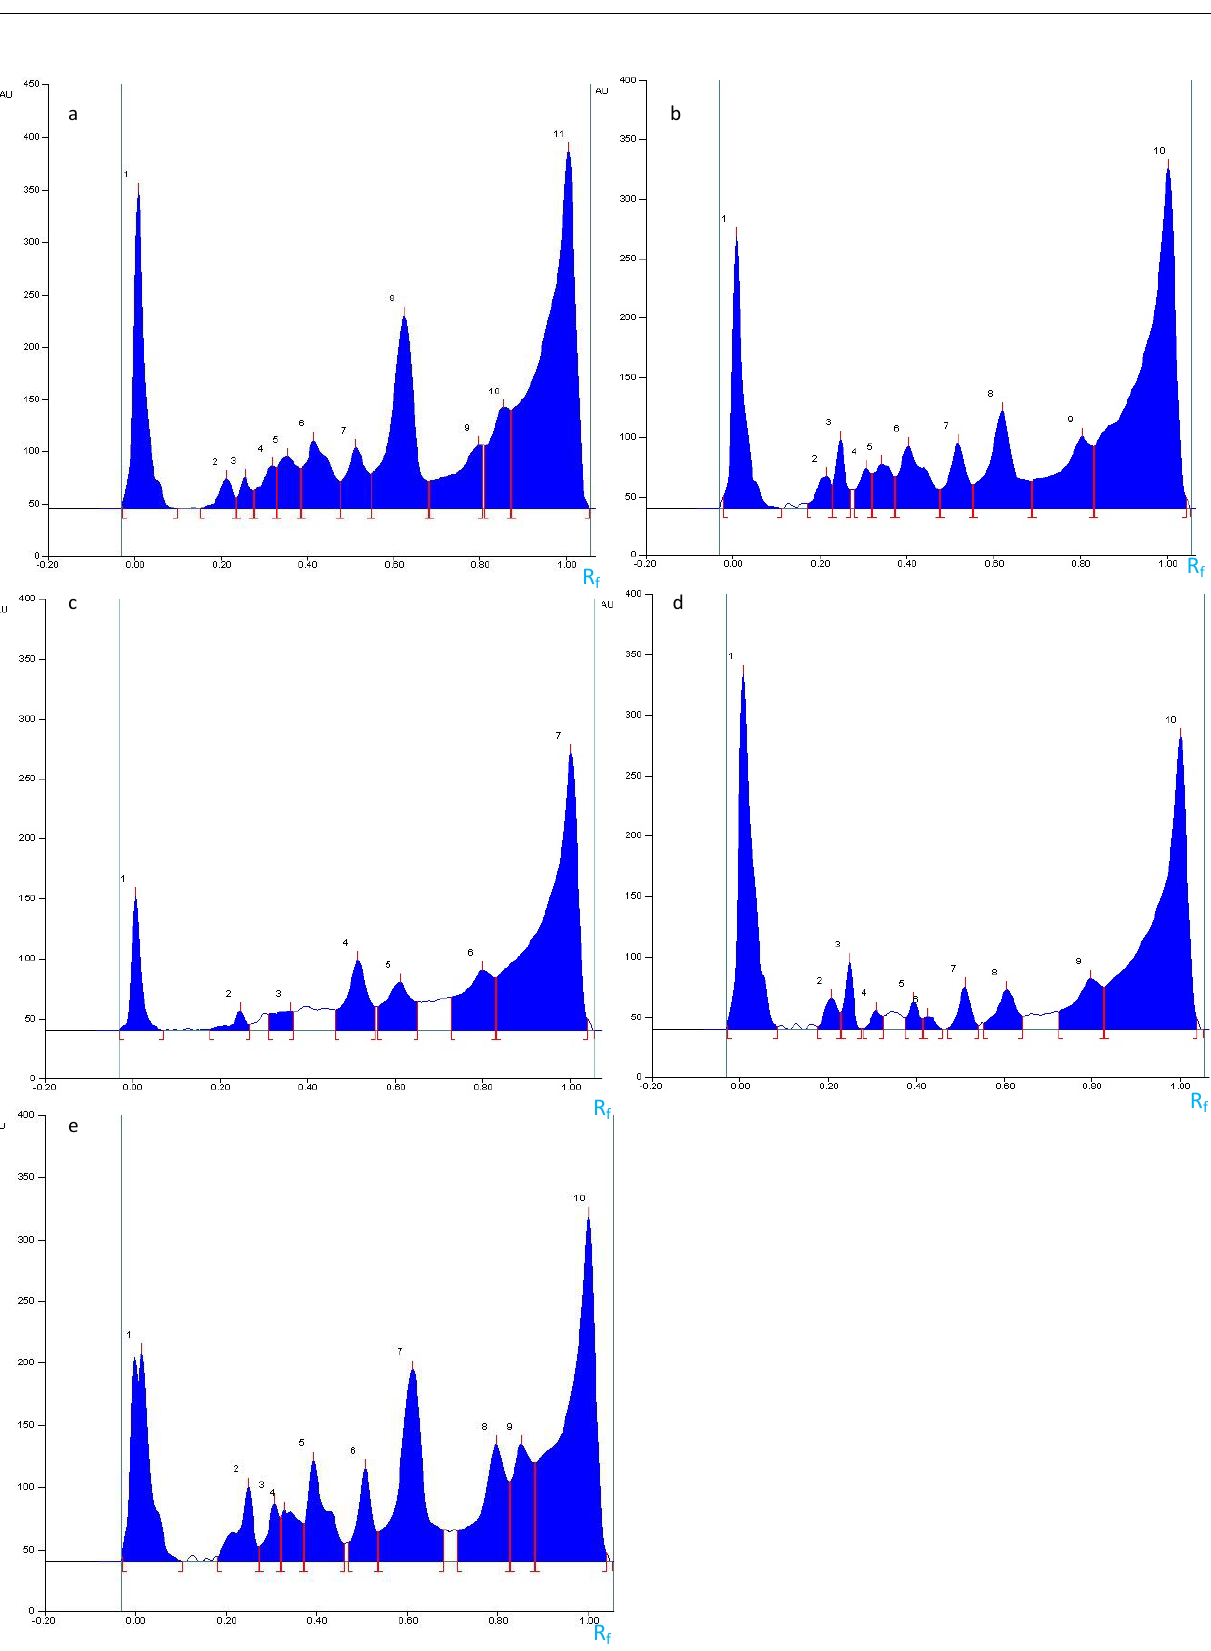
Figure 6. Densitograms of the extracts from the Zaghouan population obtained by P1 ( a ), P2 ( b ), P3 ( c ), P4 ( d ), and M1 ( e ): sequential extracts at 600 nm after visualization with anisaldehyde-H 2 SO 4 .